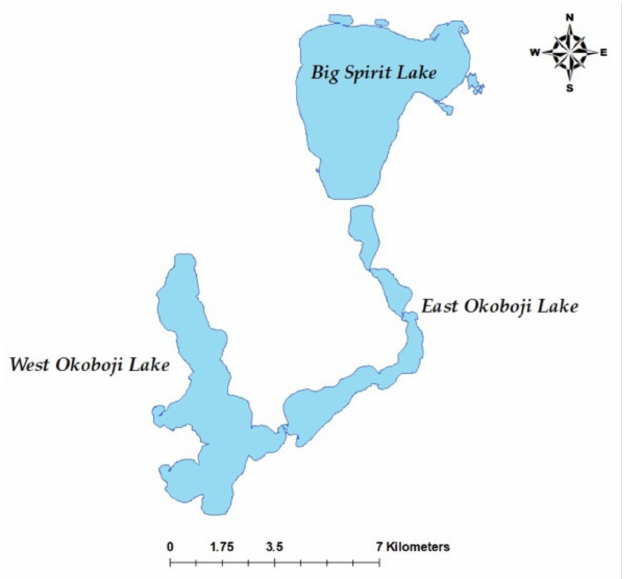
Figure 1. Map depicting layout of Big Spirit Lake (top) and East Okoboji Lake (center of the